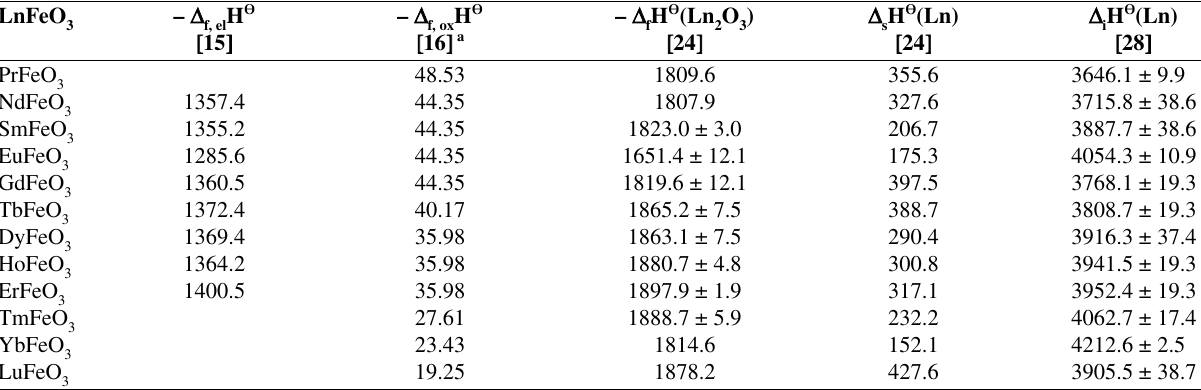
Table 3. Standard enthalpy changes of formation of lanthanide orthoferrites and sesquioxides, and of sublimation and ionization of lanthanide me- tals (all in kJ mol –1 ) LnFeO 3 PrFeO 3